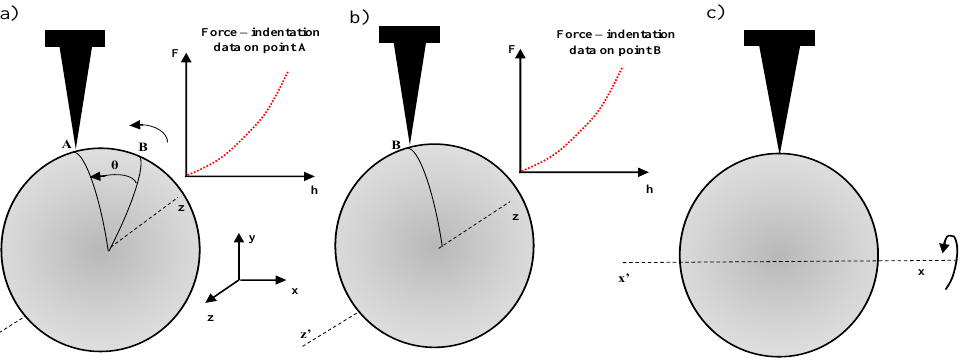
Figure 5. 3D mechanical characterization at the microscale. ( a , b ) The sample is rotated along the z -axis and force indentation curves are obtained on points A and B. ( c ) The sample is rotated along the x -axis.